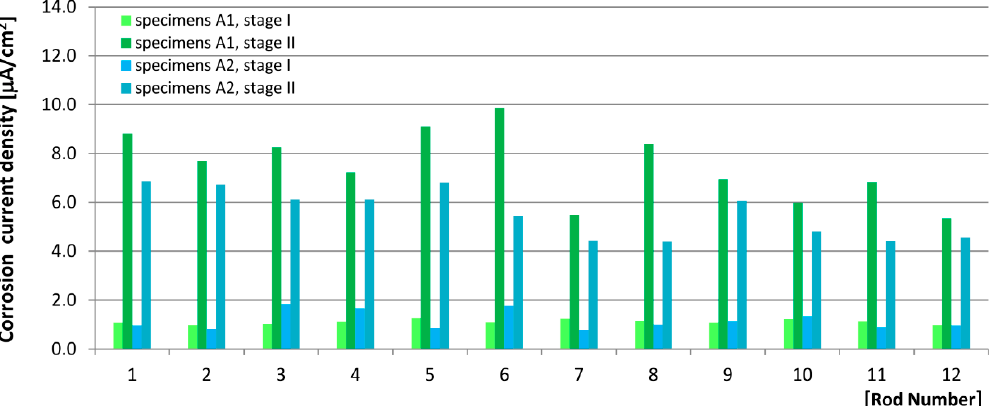
Figure 8. Results of the corrosion current density measurements.